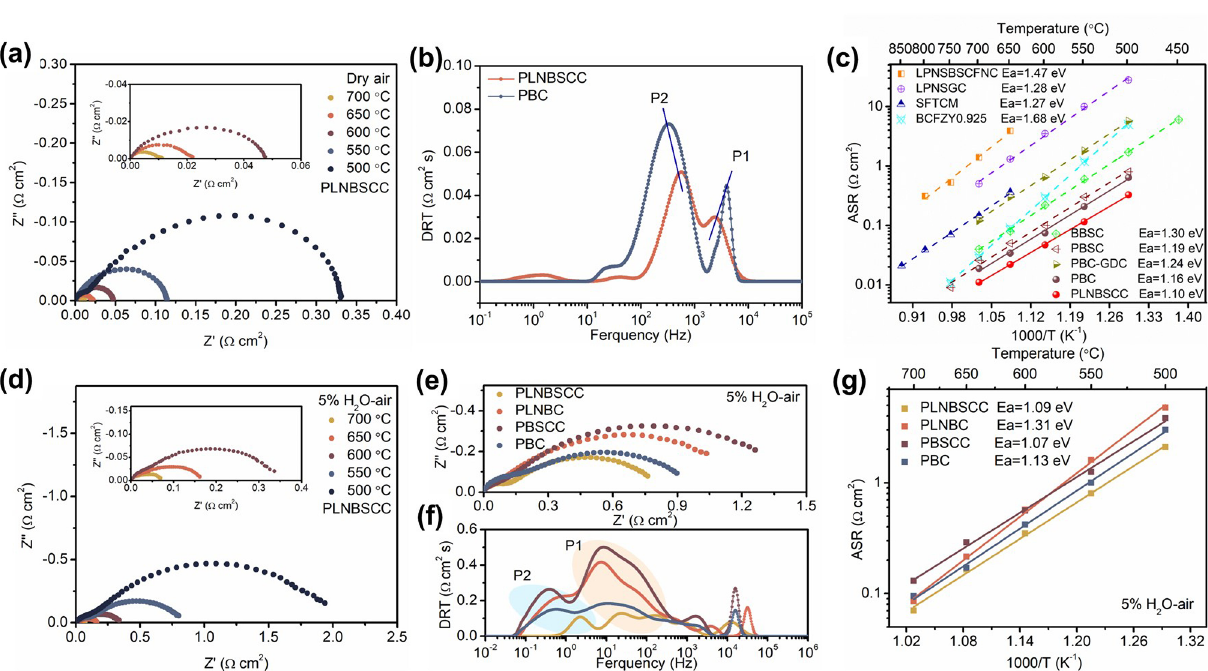
Fig. 2 a EIS curves of GDC based-supported symmetrical cell with PLNBSCC measured at 500, 550, 600, 650 and 700 °C. b DRT analysis of EIS spectra of PLNBSCC and PBC electrodes at 600 °C. c Arrhenius plots of the R p of the PLNBSCC, PBC, LPNSBSCFNC, LPNSGC, SFTNM, BCFZY0.925, BBSC, PBSC and PBC-GDC electrodes. d EIS curves of BZCYYb-based symmetric cell with PLNBSCC electrode tested at 700–500 °C in 5% H 2 O–air. e EIS comparison of PLNBSCC, PLNBC, PBSCC and PBC electrodes at 550 °C with 5% H 2 O–air, and f corresponding DRT plots. g Activation energy plots of symmetrical cells with PLNBSCC, PLNBC, PBSCC and PBC electrodes under 5% H 2 O– air at 500, 550, 600, 650 and 700